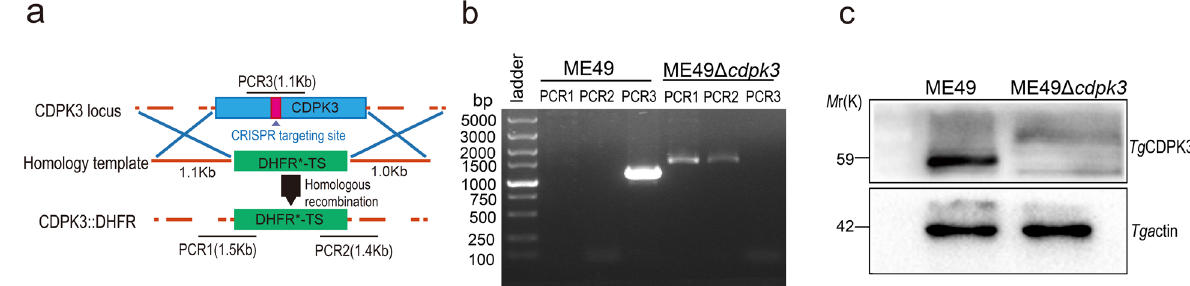
Fig. 1 CRISPR/Cas9-mediated generation of CDPK3 mutant in Toxoplasma gondii Type II ME49 strain. a Schematic of CRISPR/CAS9 strategy for replacing CDPK3 with pyrimethamine-resistant DHFR (DHFR*-TS) and PCR identi fi cation of ME49 Δ cdpk3 clones. b Diagnostic PCRs for the mutant of ME49 Δ cdpk3 T. gondii strain. PCR1 and PCR2 detect for 5 ’ and 3 ’ integration of the selection marker, while PCR3 checks for successful deletion of the CDPK3 gene. Parental wild-type ME49 strain (WT) was used as a control. c Western blotting for detection of CDPK3 expression in ME49 WT and ME49 Δ cdpk3 . T. gondii actin antibody was included as a loading control. All blots derive from the same experiment and were processed in